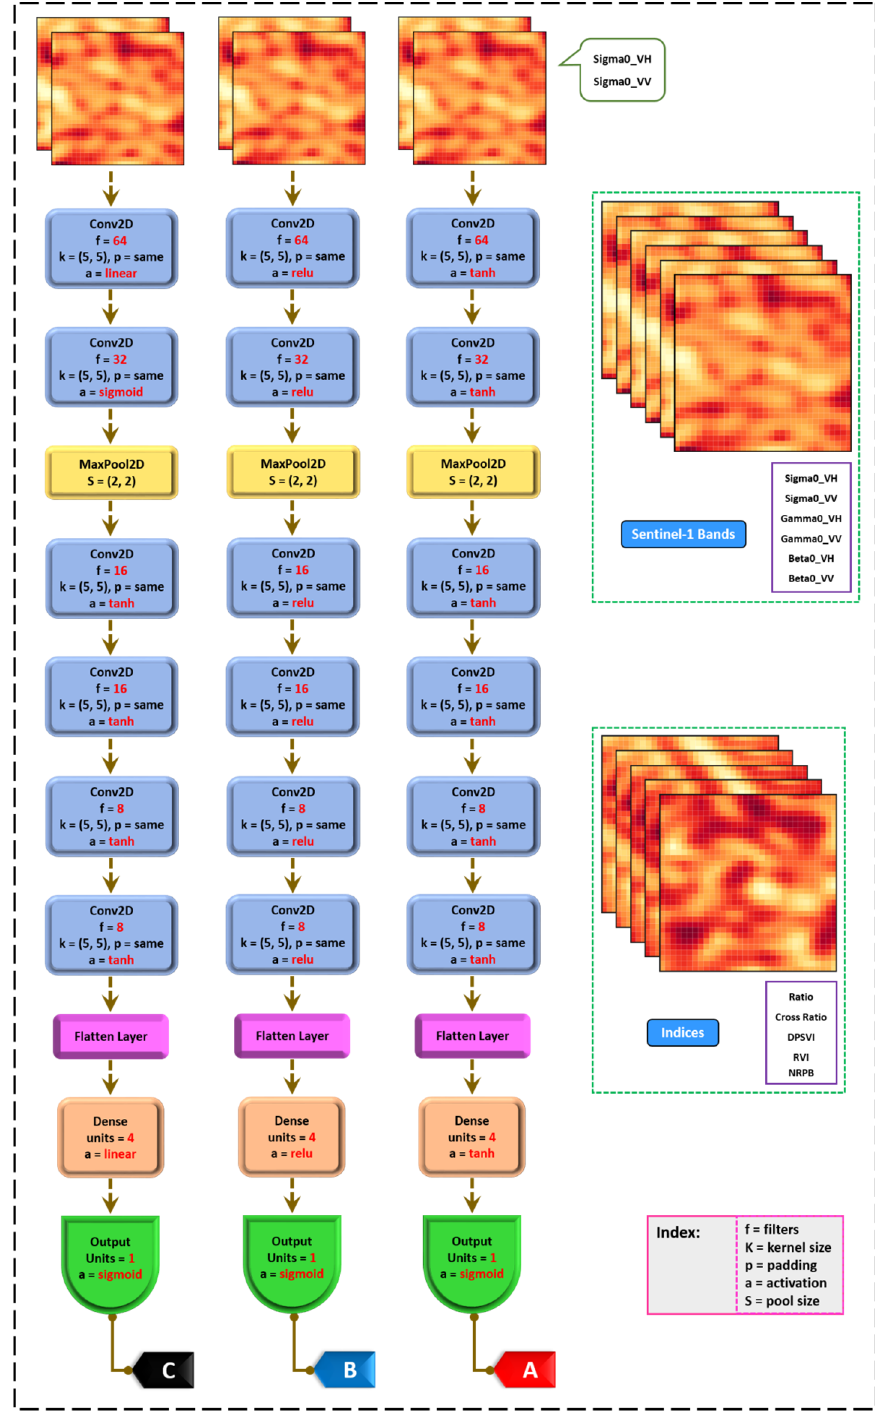
Figure 1. An overview of a convolutional neural network (CNN) architecture. No one can deny that there is a strong positive correlation between inputs, feature extraction processes, and outputs. CNN has tremendous potential to extract complex features. Accordingly, the next critical step was to select and determine the best inputs, which is done from Sentinel bands. The choice of the most suitable and appropriate ac- tivation functions for CNN will help to achieve better performance and the maximum score regression. We need to first identify the impact of each band on soil moisture